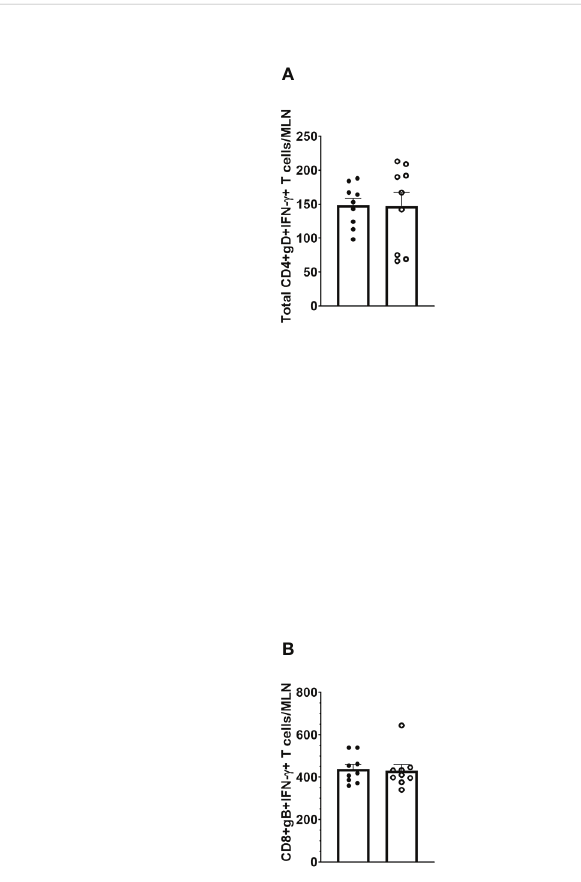
FIGURE 5 Osteopontin does not alter the function of antigen-speci fi c MLN T cells. HSV-1 infected WT and OPN KO male and female mice (n=5-9/group) were exsanguinated at day 7 PI, and the draining mandibular lymph nodes (MLN) were removed and processed into single cell